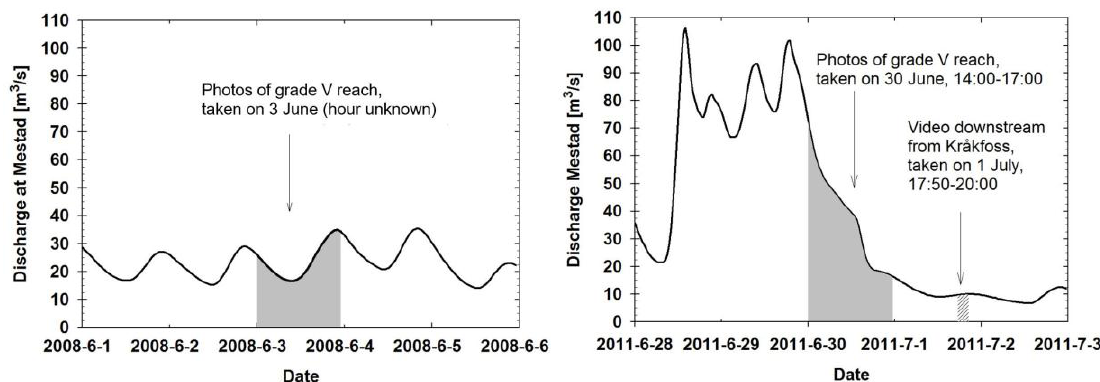
Figure 10. Measured discharges at Mestad during three documented kayaking periods. Data from BKK, time resolution 1 h (2008, left ) and 0.5 h (2011 right ). The date of the photo is marked in grey.